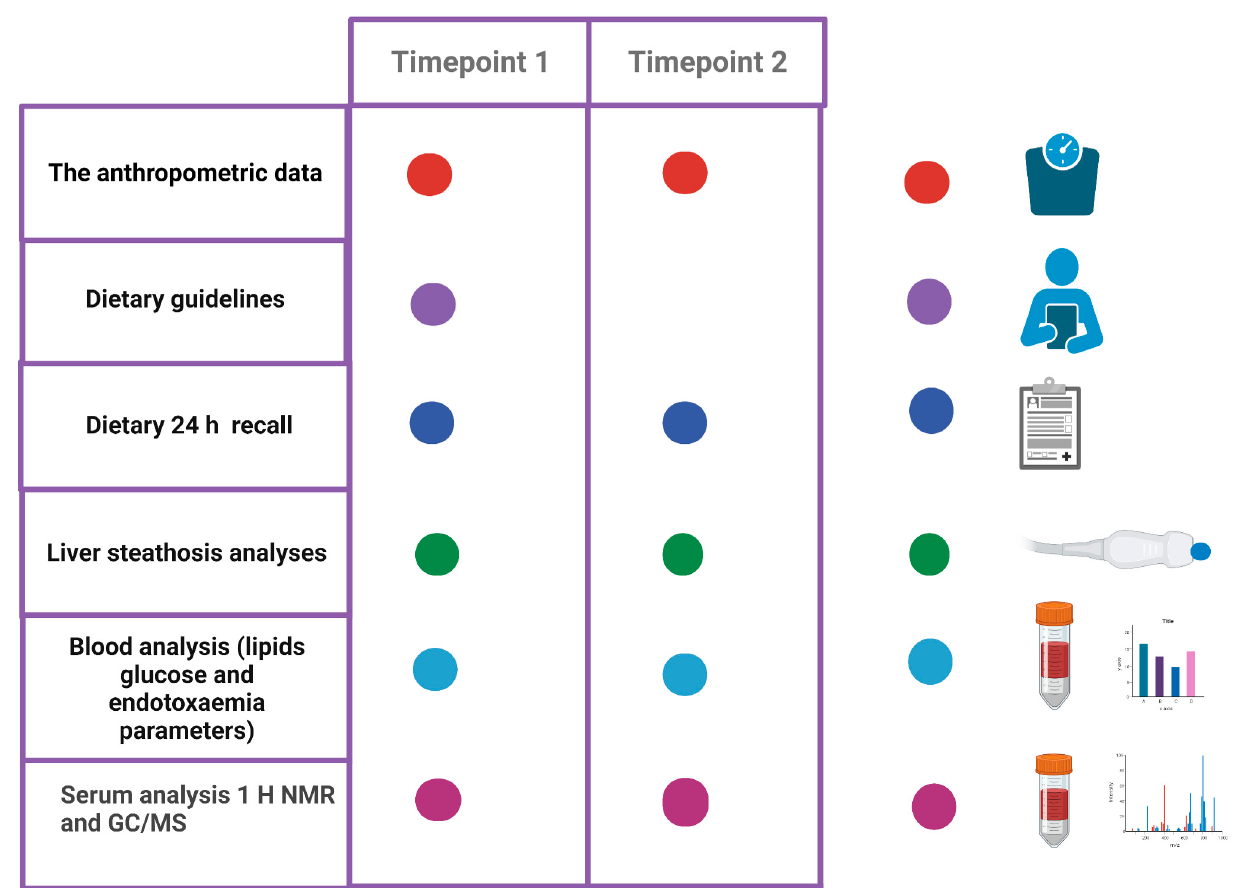
Figure 2. A scheme presenting outcome measures at study